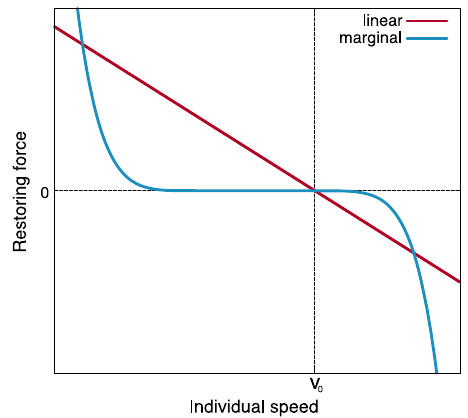
Fig. 1 Qualitative sketch of linear vs. marginal speed-restoring force. In the linear case the force pulls the speed back to its natural reference value v 0 proportionally to the deviation from v 0 . Instead, in the marginal case, the force is extremely weak for small deviations from the reference speed, while it increases very sharply for large deviations, harshly suppressing